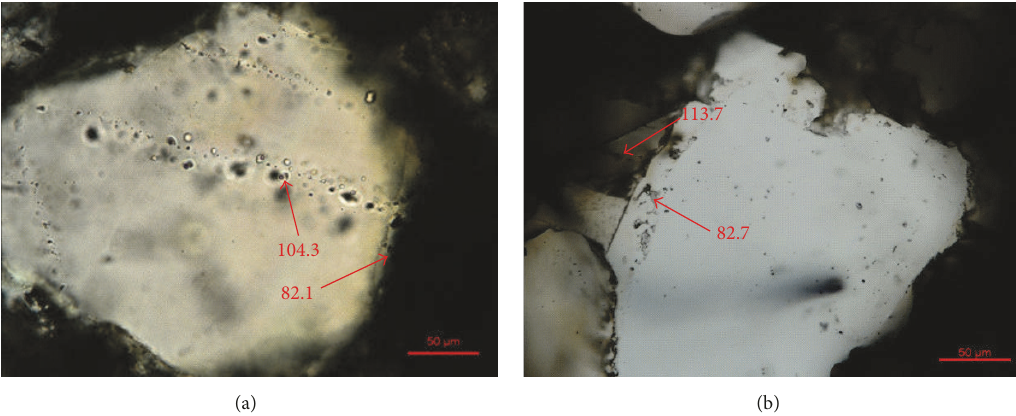
Figure 10: The inclusion characteristics of authigenic quartz in Dongying Sag . ((a) Well Y67, 2960.50 m; (b) Well S126, 3450.4 m).